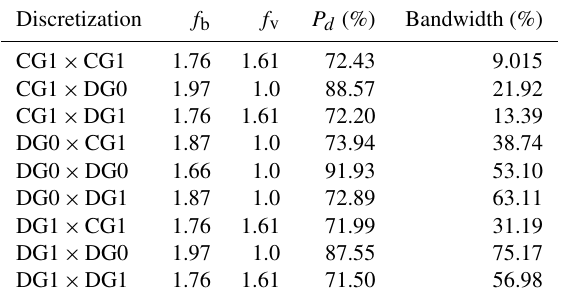
Table 5. Percentage of STREAM bandwidth and theoretical throughput achieved by the computation of integral I over 100 lay- ers on Haswell with 32 MPI processes.